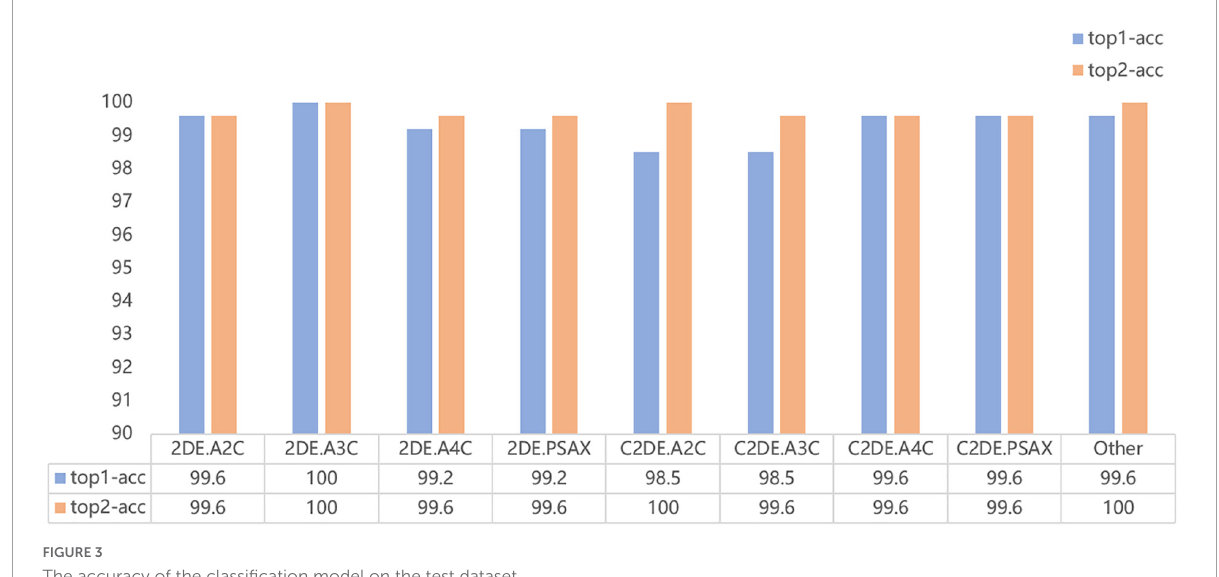
FIGURE3 The accuracy of the classification model on the test dataset.